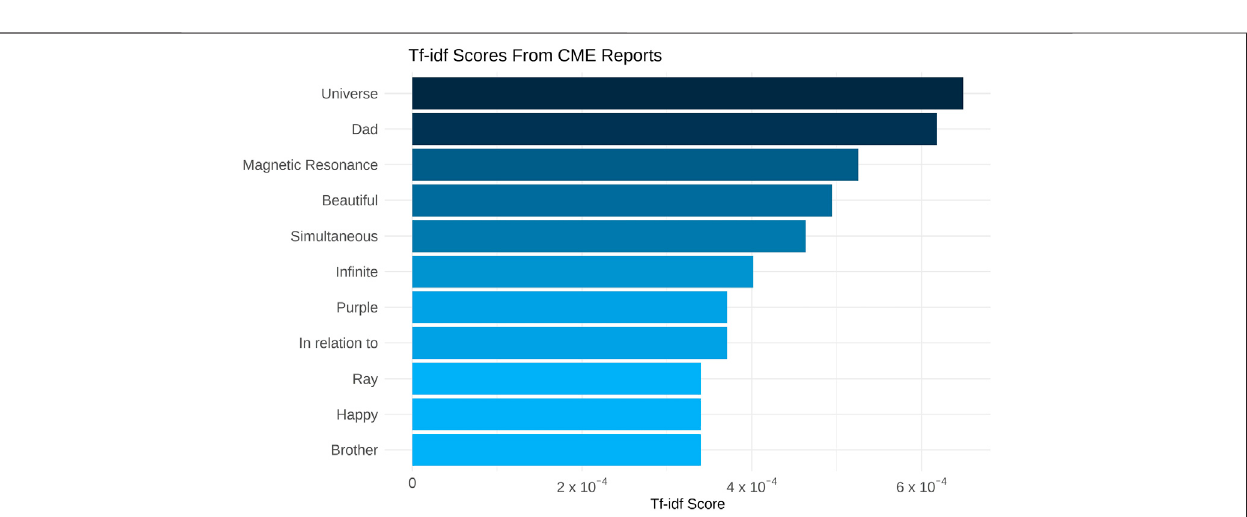
FIGURE 4 | Bar chart displaying the term-frequency inverse document frequency (tf-idf) values for the words that only appear in “ Complete Mystical Experience ” (CME) reports. Analyses were performed on Danish words and are only translated into English for display in this fi